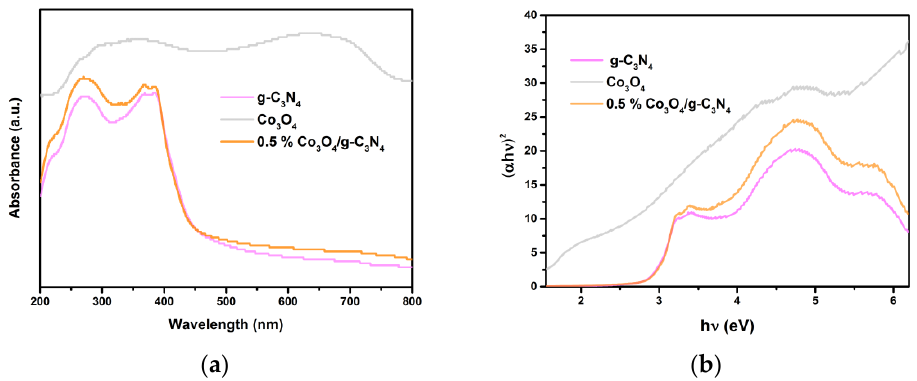
Figure 7. ( a ) UV–Vis DRS of the catalysts. ( b ) Bandgap energies of the photocatalysts. 3.7. PL